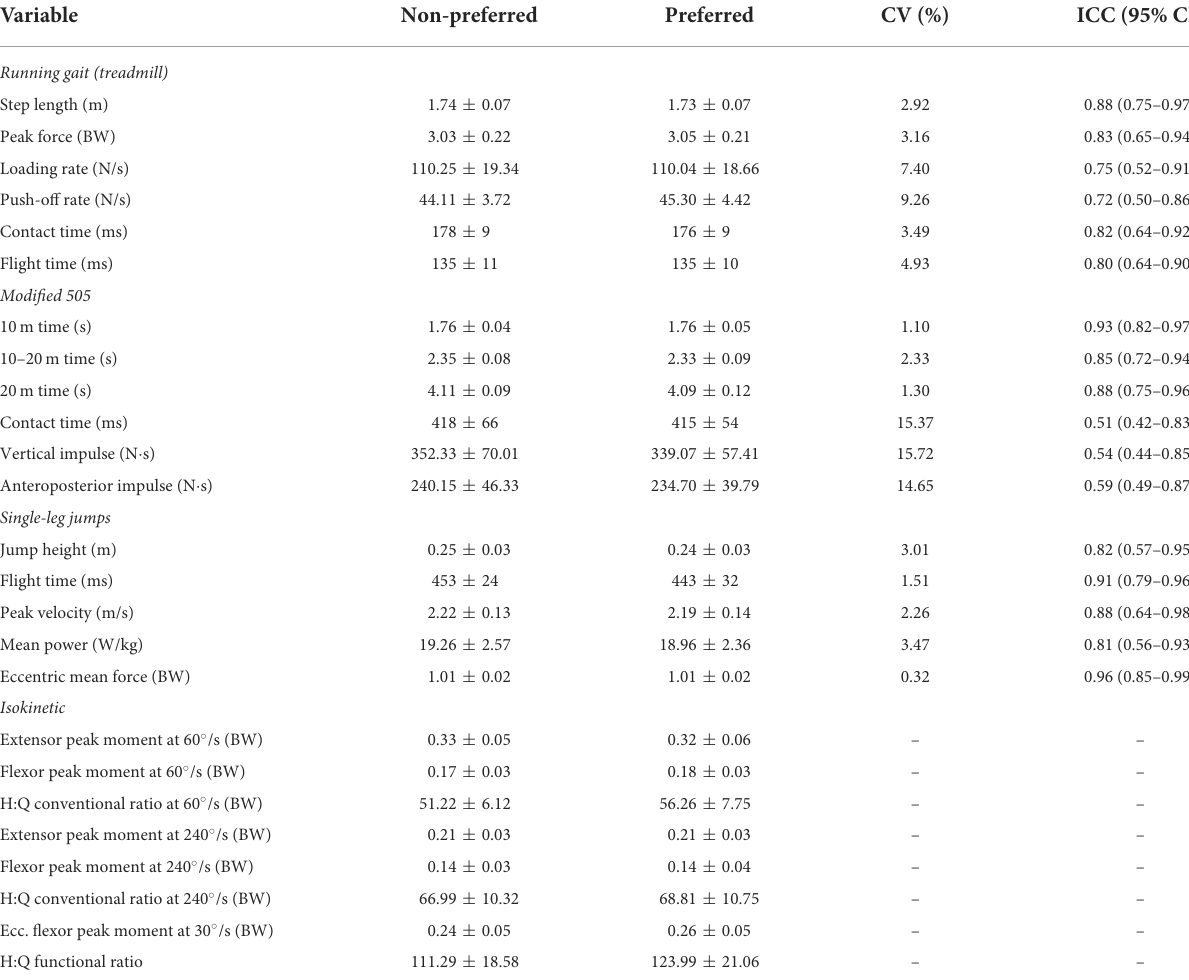
TABLE 1 Mean ± SDs for the preferred and non-preferred kicking limb and reliability data for each test variable.